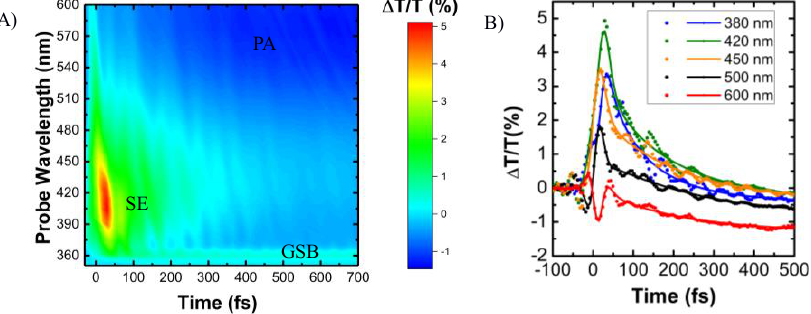
Fig 1 . Transient absorption measurements: a) 2D map, b) Transient dynamics at selected wavelengths, experimental data in circles and fittings in solid